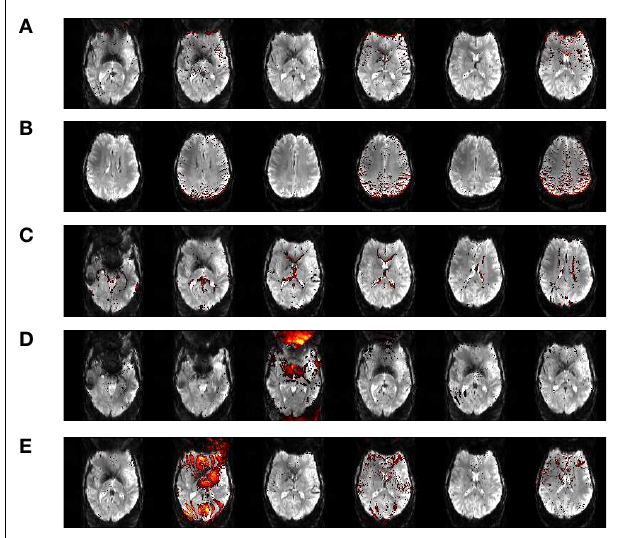
FIGURE 8 | Motion artifact components isolated in data from Chin patient C5 .These artefacts are attributed to motion in the anterior-posterior direction (A, B) , through-plane motion (C) , fluctuating Nyquist ghost (D, E)